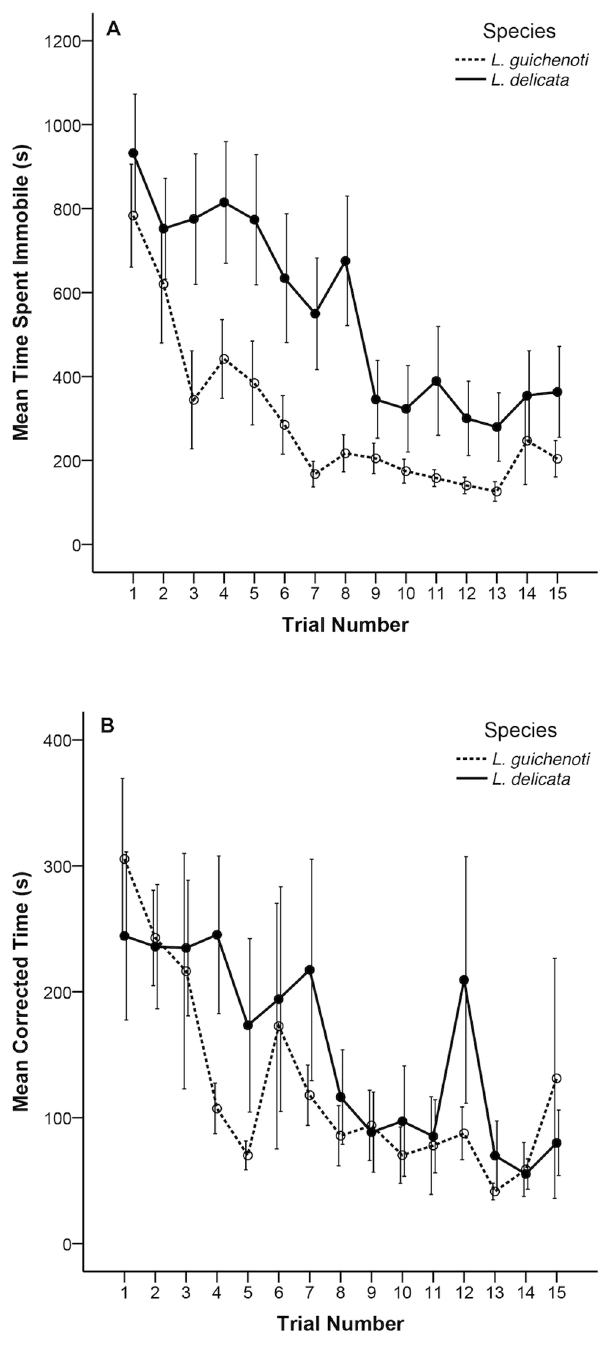
Figure 3. Panel A: Time spent immobile. Mean amount of time (in seconds) L. delicata and L. guichenoti spent immobile in each maze trial. Panel B: Latency times. Mean latency times (in seconds) for L. delicata and L. guichenoti corrected for the amount of time spent immobile in each trial. Solid lines represent L. delicata and broken lines represent L. guichenoti . Error bars represent standard errors for each species in each trial. of maze trials increases. We used a robust variance estimator, which reduces the risk of confounding effects if the empirical working correlation matrix deviates from the theoretically assumed one. Gender has the potential to influence maze learning in other taxa